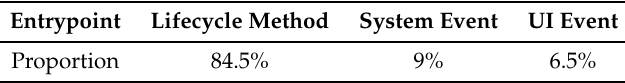
Table 2. Entry point statistics for privacy leakages.